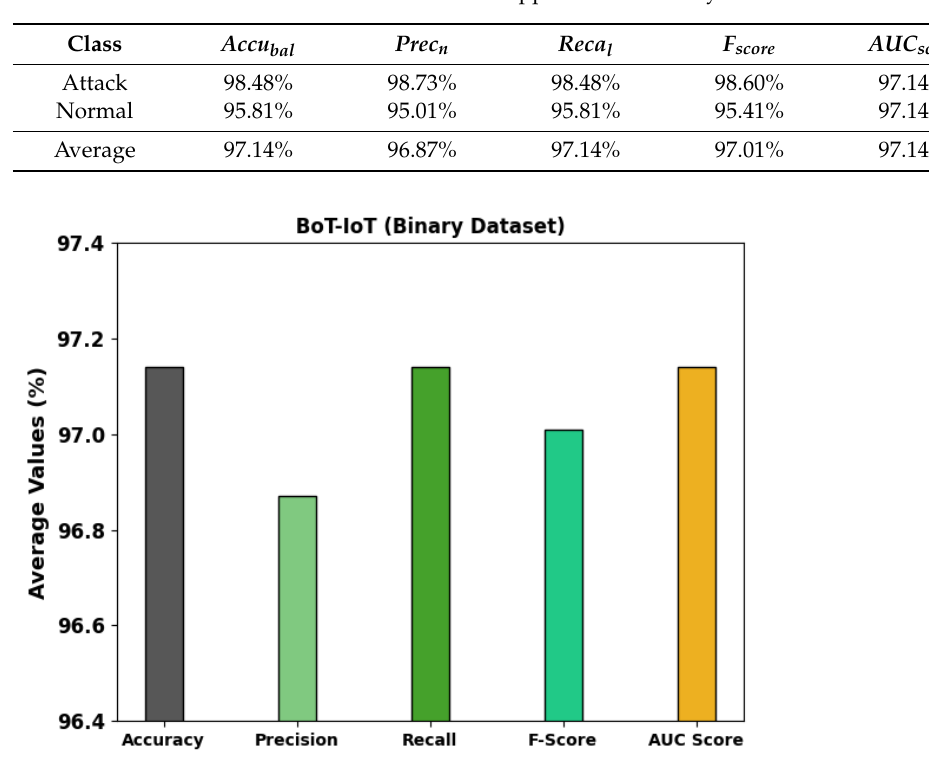
Figure 4. Average results of the H3SC-DLIDS approach on a binary dataset.